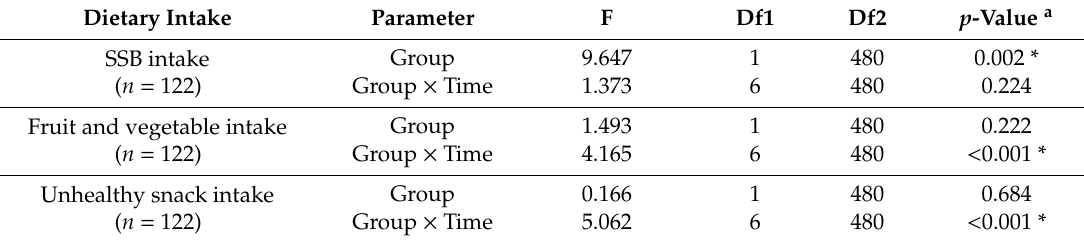
Table 5. E ff ect of REDUCE intervention program on dietary intake per